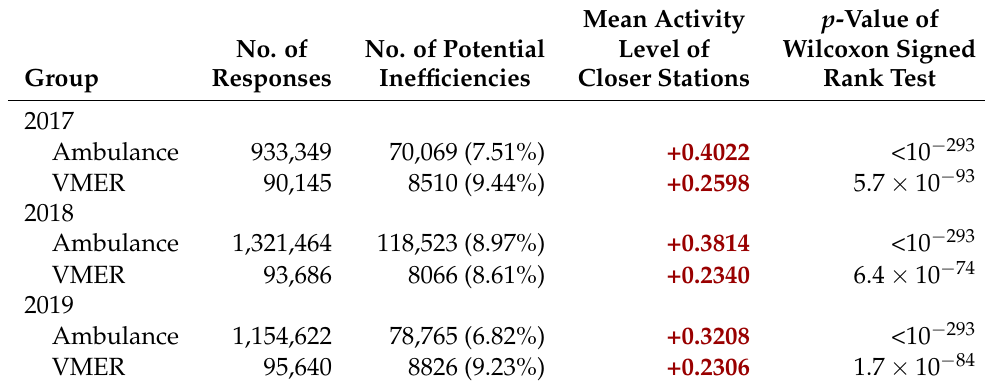
Table 1. Overall statistics on potential inefficiencies detected on ambulances and VMER vehicles for the years 2017–2019. Bold values indicate significance at a 0.01 level. Red values indicate positive activity